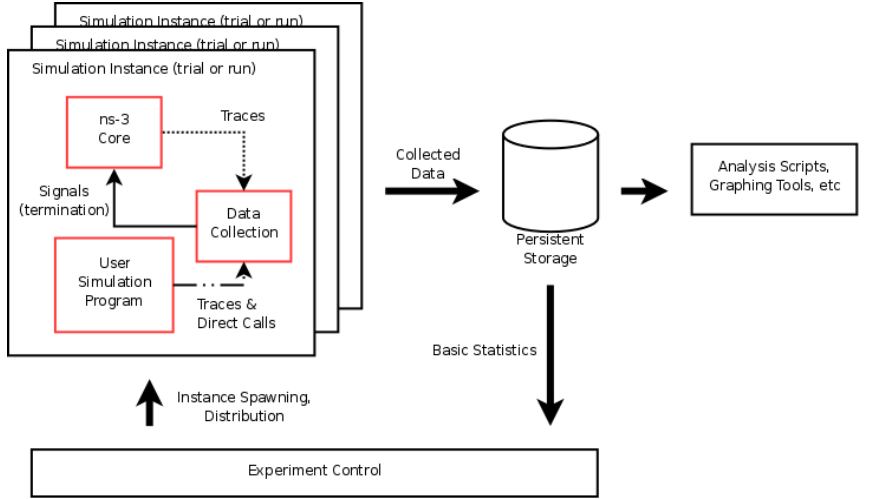
Figure 2. The statistical framework of NS3